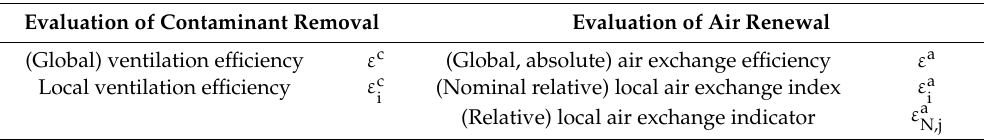
Table 3. Nomenclature of ventilation e ff